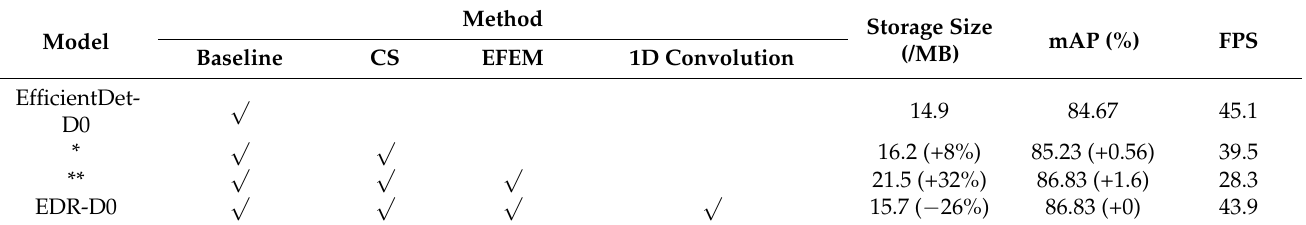
Table 2. The results of ablation experiments.